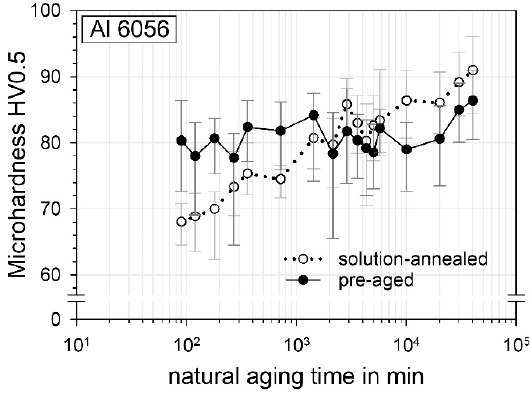
Figure 2. Microhardness of the 6056 aluminum alloy in solution-annealed and pre-aged conditions as a function of the natural aging time. Depicted are the mean, minimum and maximum values of the microhardness. The hardness of the solution-annealed sample increases continuously along with the increasing aging time, whereas for the pre-aged condition, the hardness remains almost constant during the first weeks.